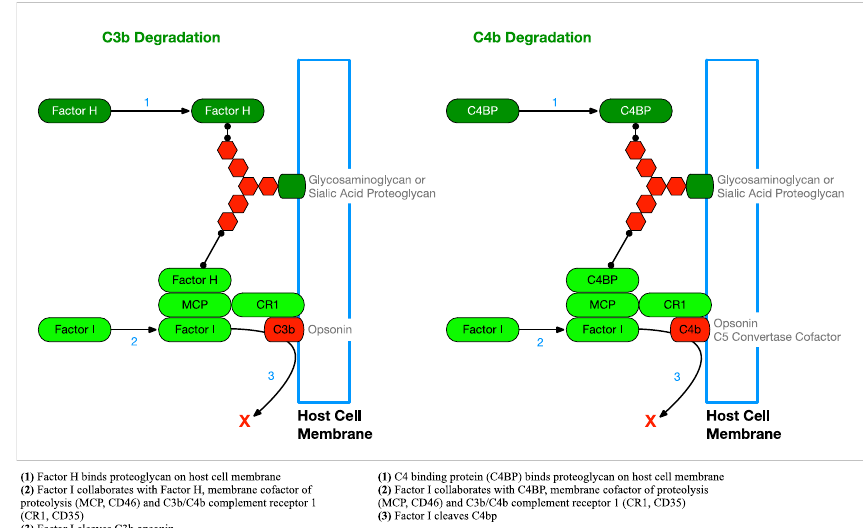
Figure 8. Host Cell Regulation of C3b and C4b Opsonization—Mammalian host cells must be able to degrade C3b (an opsonin) to prevent phagocytosis and C4b (a C5 convertase cofactor) to prevent membrane attack complex (MAC) formation [37]. Borrelia burgdorferi has been able to co-opt this regulatory system, avoiding phagocytosis by binding Factor H (FH) with complement regulator acquiring surface proteins (CRASPs) expressed on the bacterial surface. Host cells are also able to remove established C3 convertases. FH binds SA or GAG proteoglycans on the cell surface and cleaves Bb from AP C3bBb C3 convertases. In a similar way, C4BP binds proteoglycans on the cell surface and cleaves C2a from CP and LP C4b2a C3 convertases (Figure 9). The remaining C3b and C4b opsonins can then be degraded by FI, as described above and as shown in Figure 8.